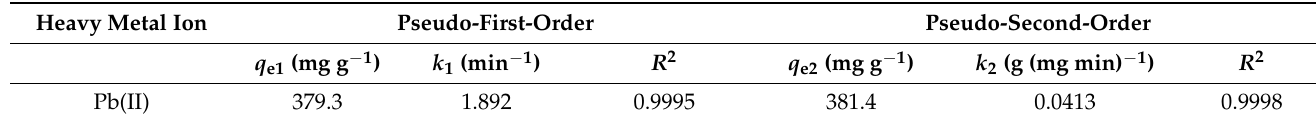
Table 1. Adsorption kinetics parameters of the fitted pseudo-first-order and pseudo-second- order models.